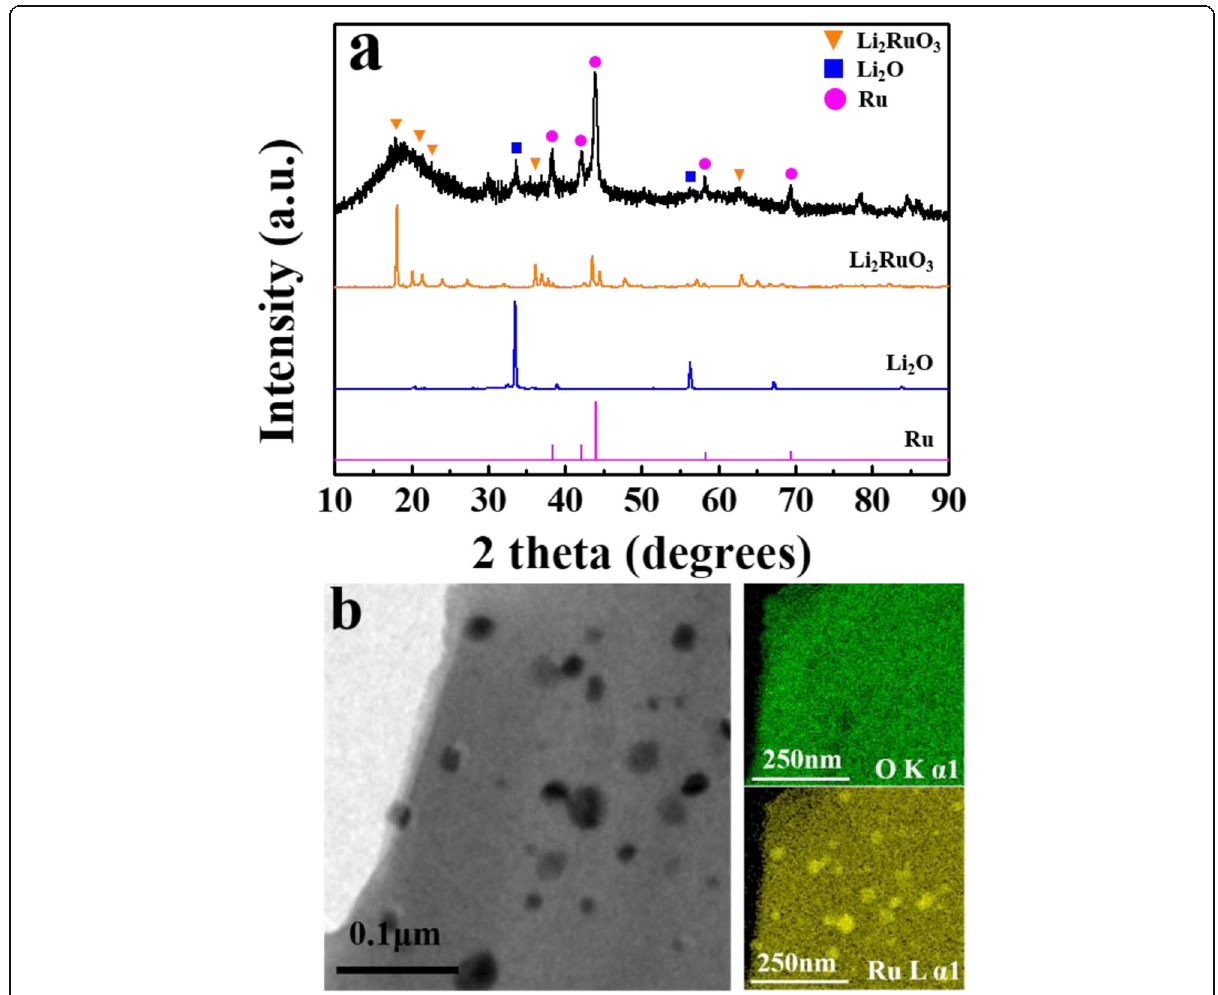
Fig. 1 a XRD patterns of the lithia/Li 2 RuO 3 nanocomposite compared with Li 2 RuO 3 , Li 2 O, and Ru. b TEM images and EDS element mapping of the